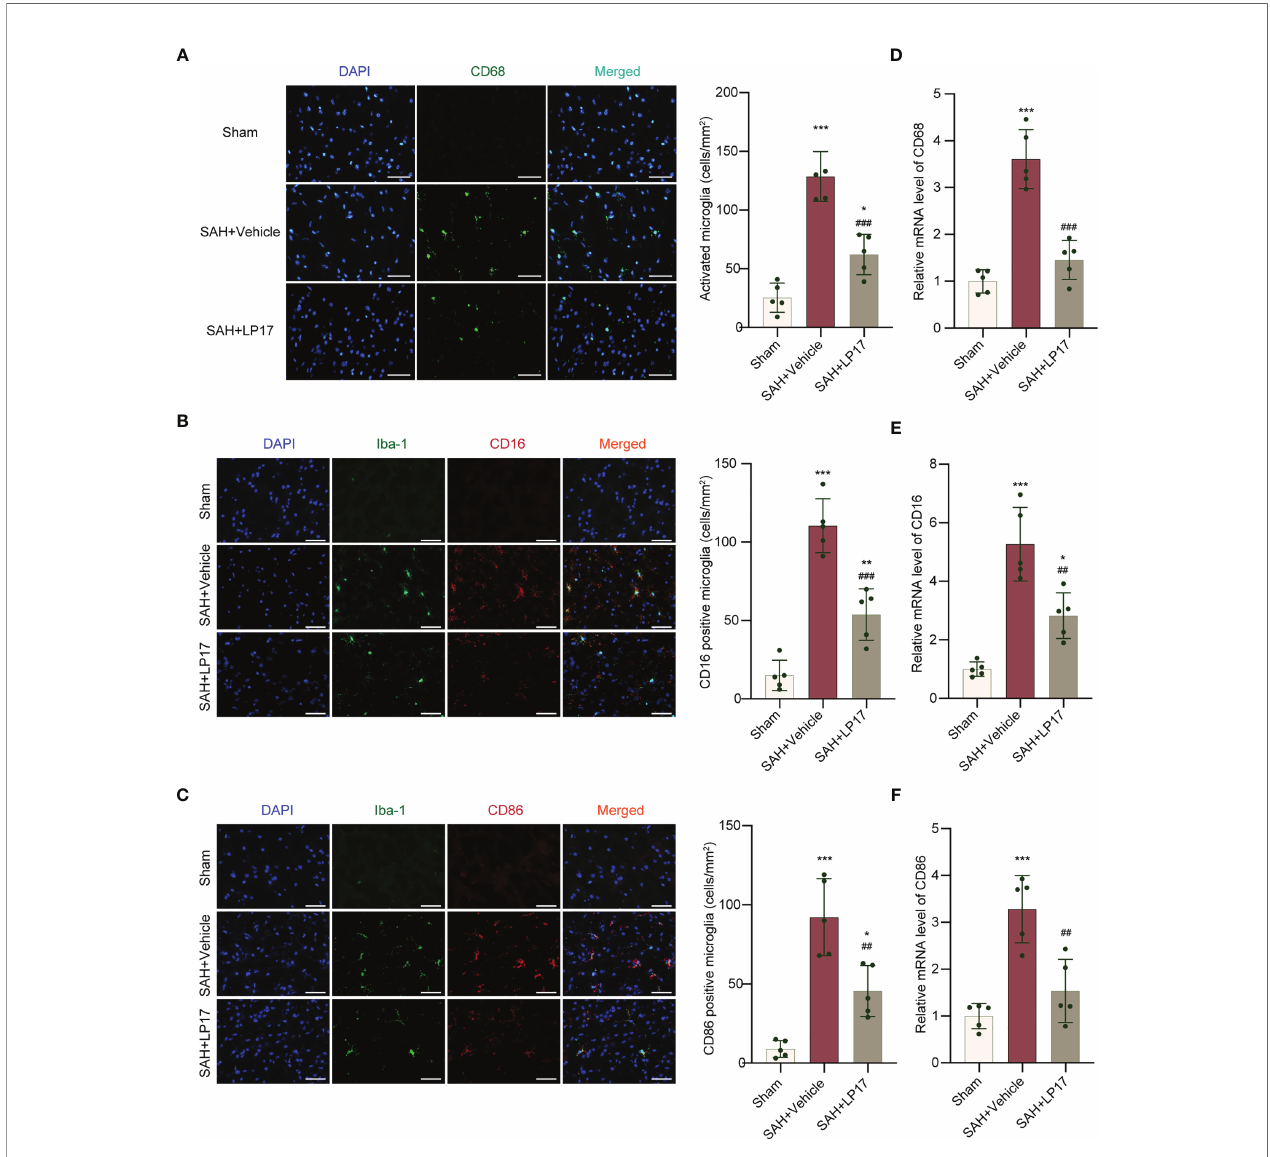
FIGURE 4 | LP17 treatment inhibited activation and proin fl ammatory subtype transition of microglia. (A) Representative photograph and quantitative analysis showed the CD68 positive cell (green) in different groups. n = 5/group. (B) Representative photograph and quantitative analysis showed the co-localization of CD16 positive cell (red) with Iba-1 (green) in different groups. n = 5/group. (C) Representative photograph and quantitative analysis showed the co-localization of CD86 positive cell (red) with Iba-1 (green) in different groups. n = 5/group. (D – F) . Relative mRNA levels of proin fl ammatory subtype microglia marker genes (CD68, CD16, CD86). n = 5/group. Data are expressed as mean ± SD. *P < 0.05, **P < 0.01, ***P < 0.001 vs Sham group; ## P < 0.01, ### P < 0.001 vs SAH+vehicle group. Scale bar = 50 m